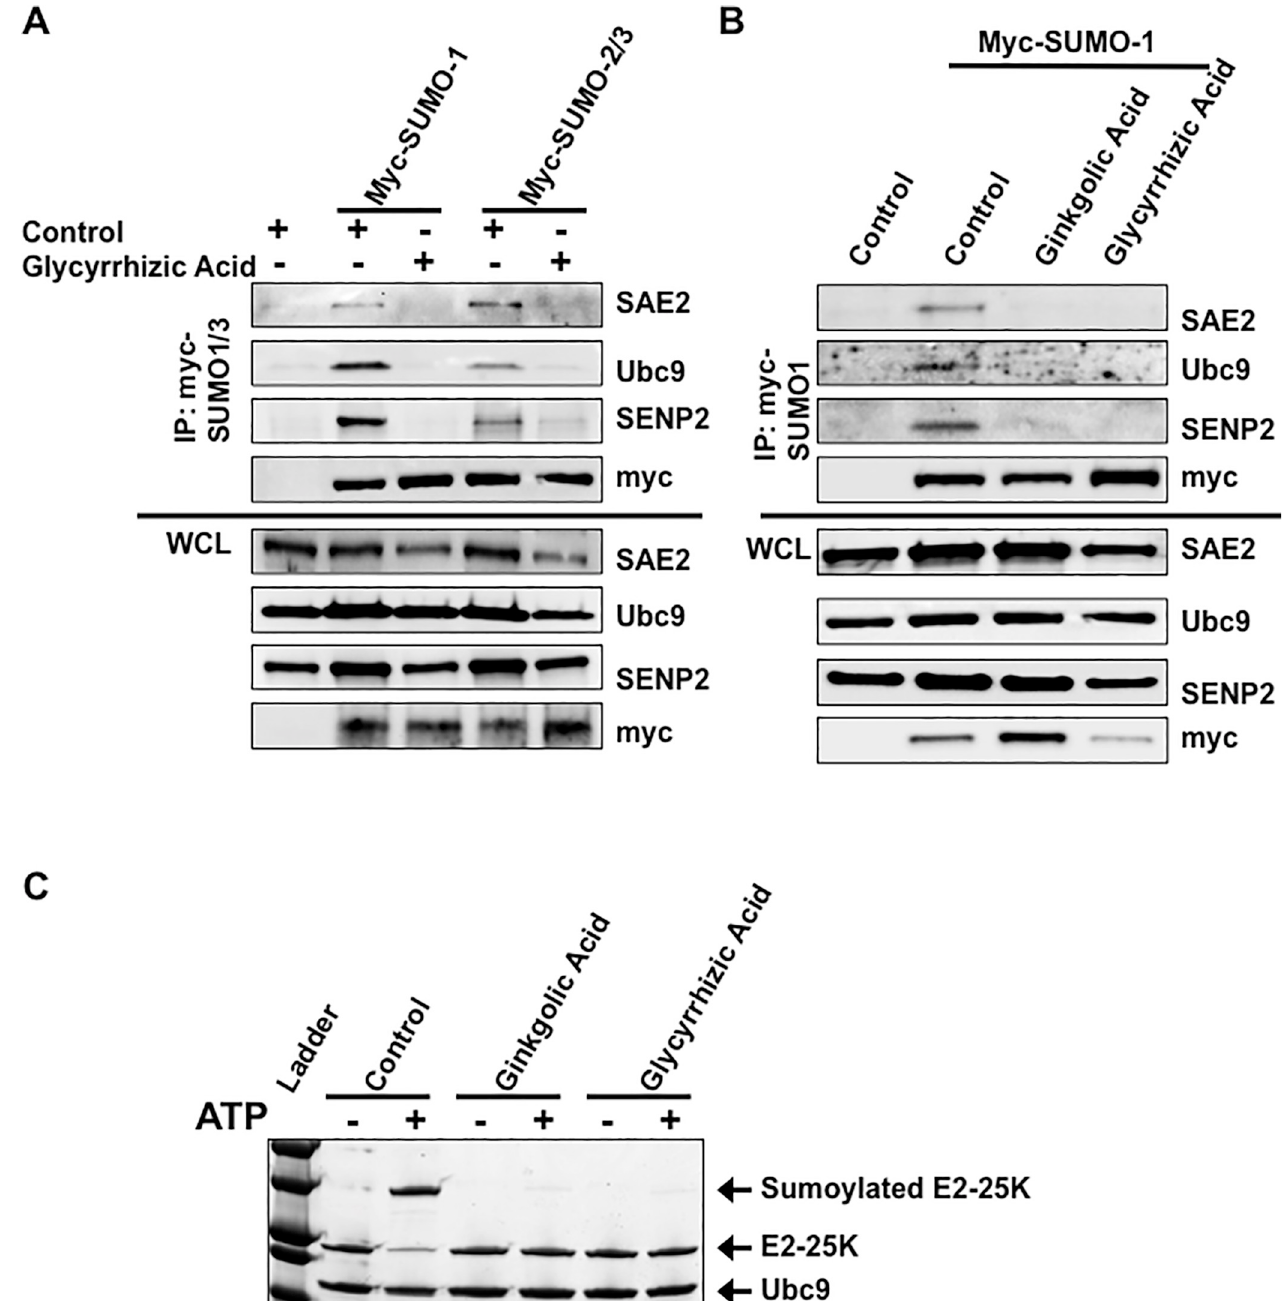
Fig 4. Glycyrrhizic acid inhibited SUMO from interacting with the SUMO machinery and was sufficient to inhibit sumoylation processes in vitro . HEK 293 cells were transfected with SAE1/2, Ubc9, SENP2, and myc-SUMO-1 or myc-SUMO-3 expression constructs and treated with A) the vehicle control or glycyrrhizic acid and B) the vehicle control, ginkgolic acid, or glycyrrhizic acid. Native immunoprecipitations were performed to pull-down all myc-SUMO- interacting proteins. Western blot analyses were performed to detect SAE1, Ubc9, and SENP2 in the immunoprecipitants and whole cell lysates (WCL). C) Reactions of purified E2-25K, a ubiquitin-conjugating E3 enzyme that is a known target for sumoylation, SUMO-activating enzyme (SAE1/2), and SUMO- conjugating enzyme (Ubc9) were incubated in the presence or absence of ATP, which is required for protein sumoylation. Reactions were treated with the vehicle control, ginkgolic acid, or glycyrrhizic acid. Following incubation, reactions were denatured, separated by SDS-PAGE, and bands were visualized with a Coomassie Blue stain.